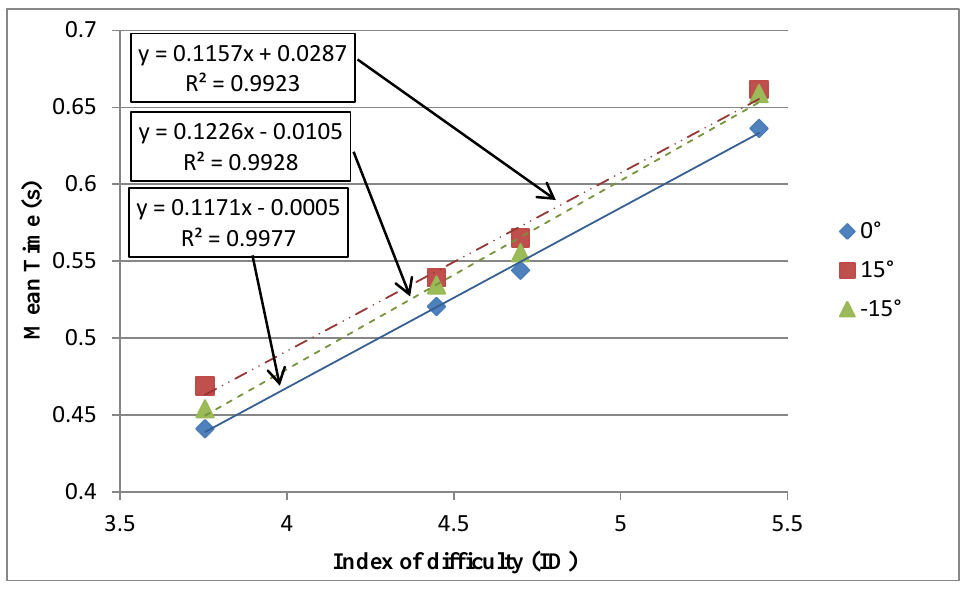
Figure 8. Mean time of the teach pen operation at different IDs and inclination